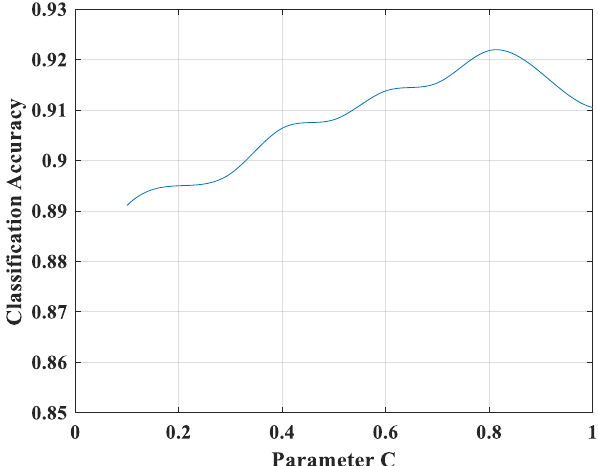
Figure 5. The relationship between the parameter C and the final classification accuracy of the model.